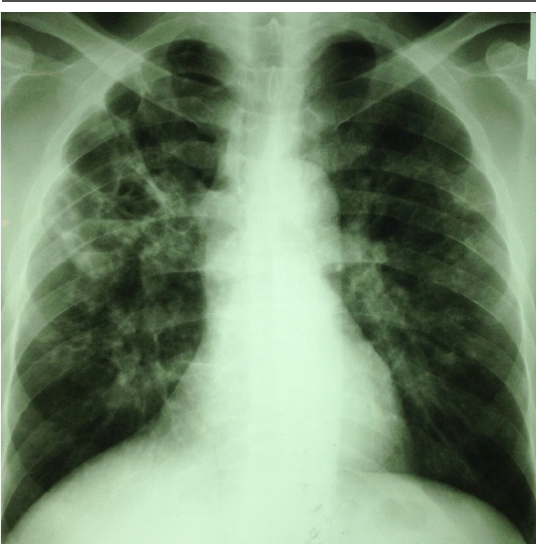
Figure 3. Patient’s Repeat Chest X-ray After Two Weeks of Anti- biotics, Showing Marked Radiological